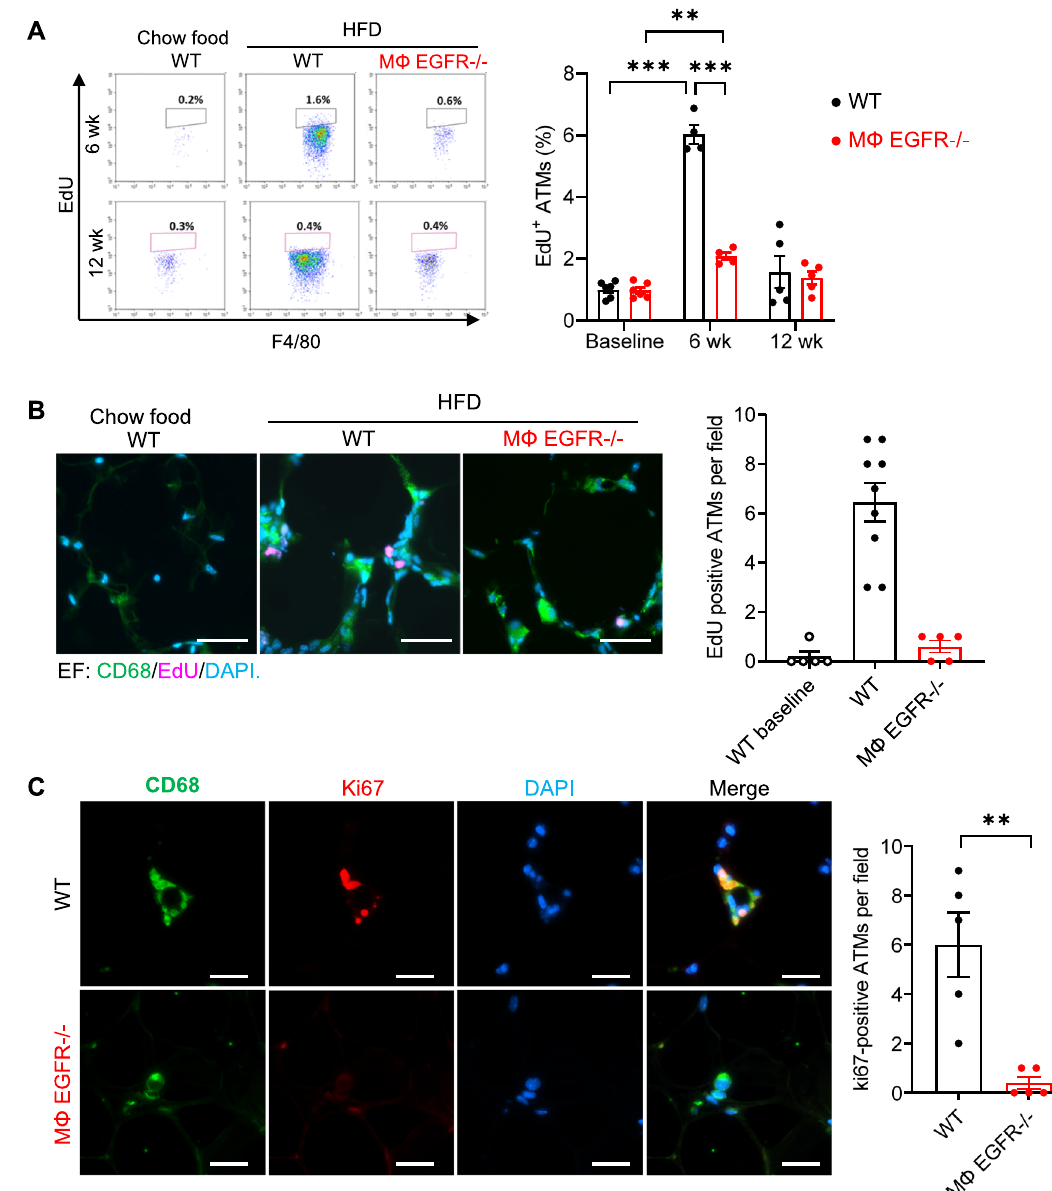
Fig. 8 | Mice with myeloid EGFR deletion had decreased ATM proliferation in diet-induced obesity. WT and M Φ EGFR − / − mice were fed the HFD for 6 or 12 weeks. A The signi fi cantly increased proliferating rate of ATMs in EF (EdU positivecells)seeninWTmiceat6weekswasmarkedlyattenuatedinM Φ EGFR − / − mice. N =4 and 5 and6. B , C A decreased rate of proliferation in M Φ EGFR − / − mice